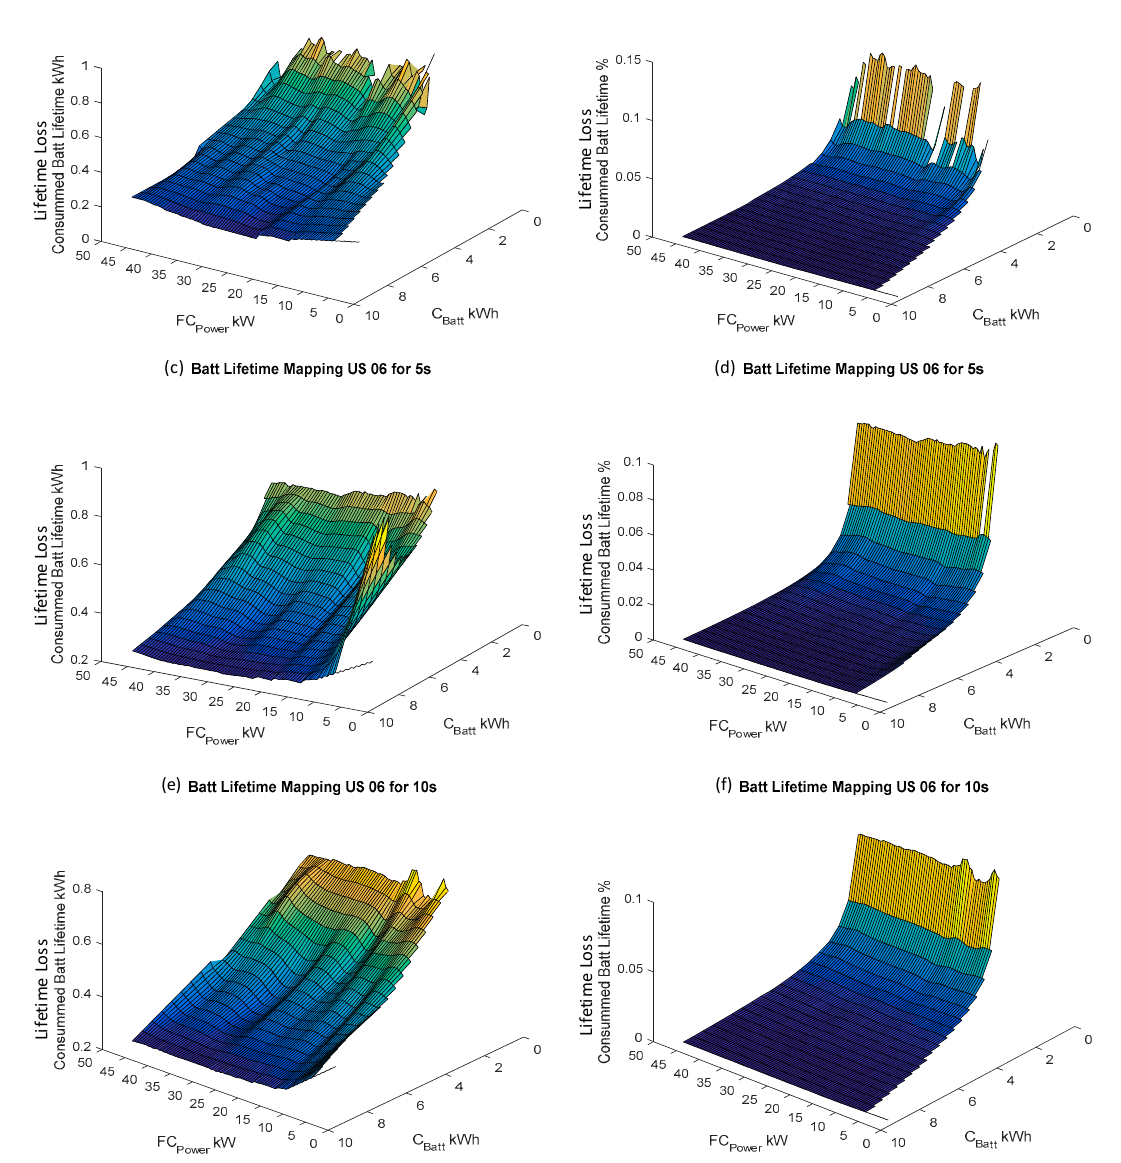
Figure 11. Design results (fuel cell power FC power and battery capacity C Batt ) considering lifetime loss (KW/h or %)—US 06 driving cycle under different FC dynamics (1 s, 5 s and 10 s). ( a ) Result mapping with battery lifetime loss (KW / h) and FC dynamic 1 s. ( b ) Result mapping with battery lifetime loss (%) and FC dynamic 1 s. ( c ) Result mapping with battery lifetime loss (KW / h) and FC dynamic 5 s. ( d ) Result mapping with battery lifetime loss (%) and FC dynamic 5 s. ( e ) Result mapping with battery lifetime loss (KW / h) and FC dynamic 10 s. ( f ) Result mapping with battery lifetime loss (%) and FC dynamic 10